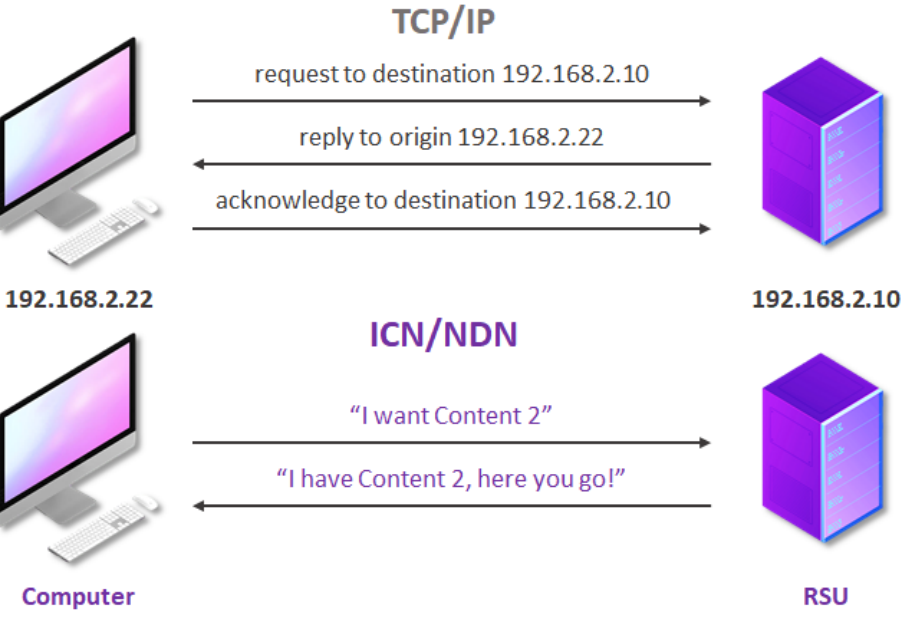
Figure 1. TCP/IP vs. NDN